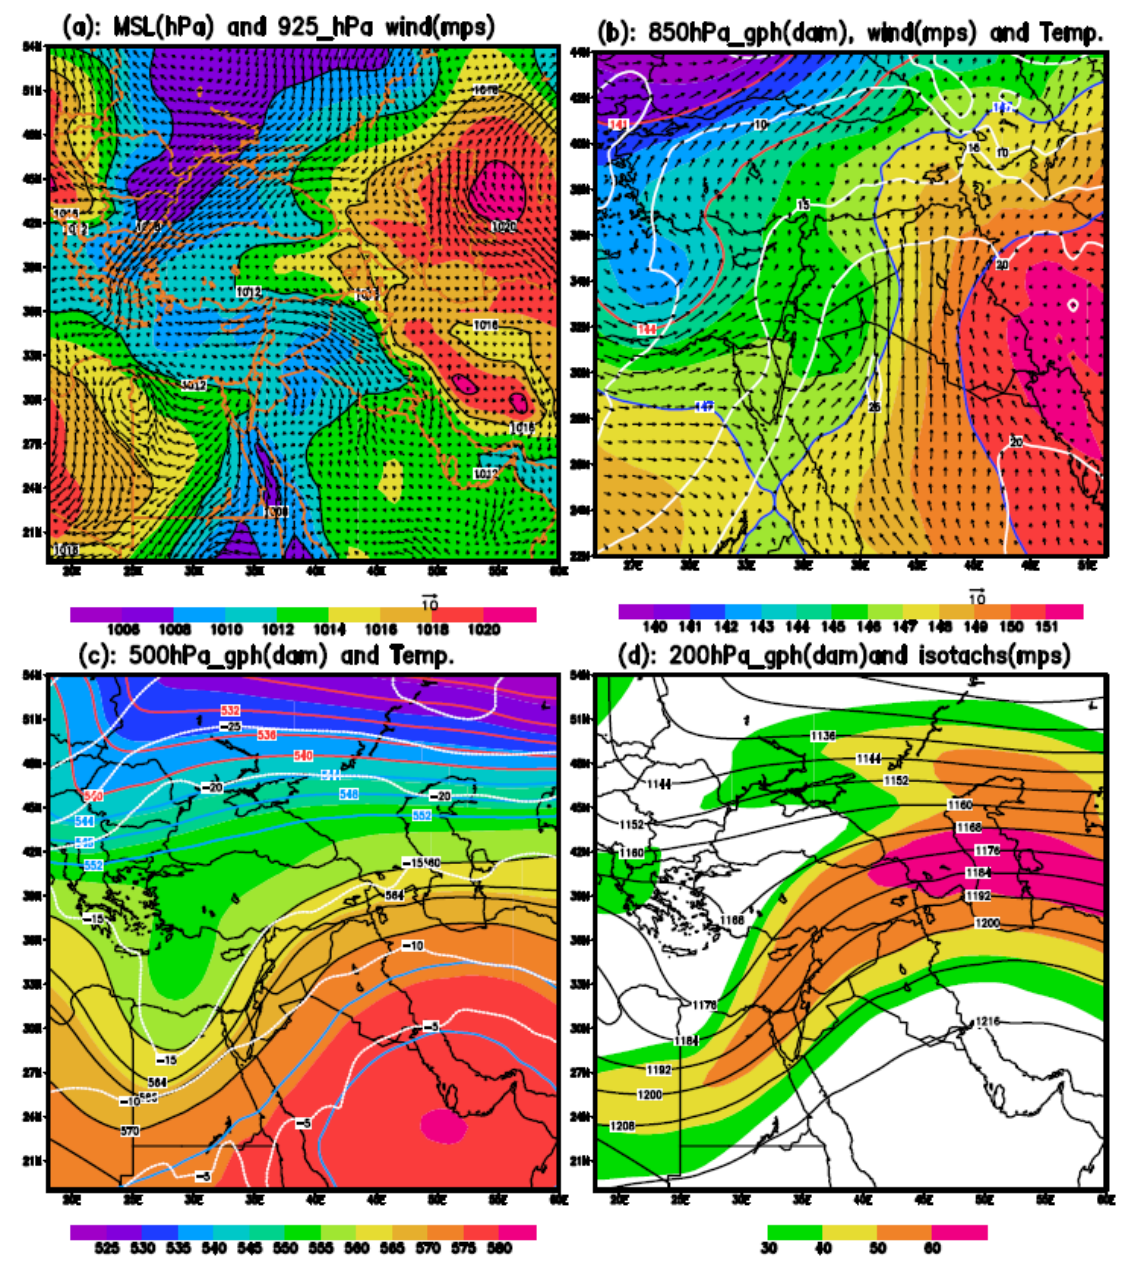
Figure A3. Same as Figure 10 but for 00 UTC 28 October 2017. At 00 UTC on 29 October 2017, a massive low-pressure system was located over Europe, with two troughs extending over the Mediterranean Sea and the Caspian Sea (CS). Furthermore, a weak cyclone centered over Iraq (Figure A4a) with a cold front (extending southward from Iraq and southeast to the northern part of the RS) producing extreme north-northwesterly winds over Iraq and the northwest of Saudi Arabia. Moreover, there were two small warm and cold fronts over Eastern Iraq, and a warm front extending northeastward from Northwest Iraq to Northwest Iran (the fronts are not drawn on the Figure A4a). The formation of strong winds in this area can result in severe dust storms that move with the upper winds and affect the wind’s downstream areas after